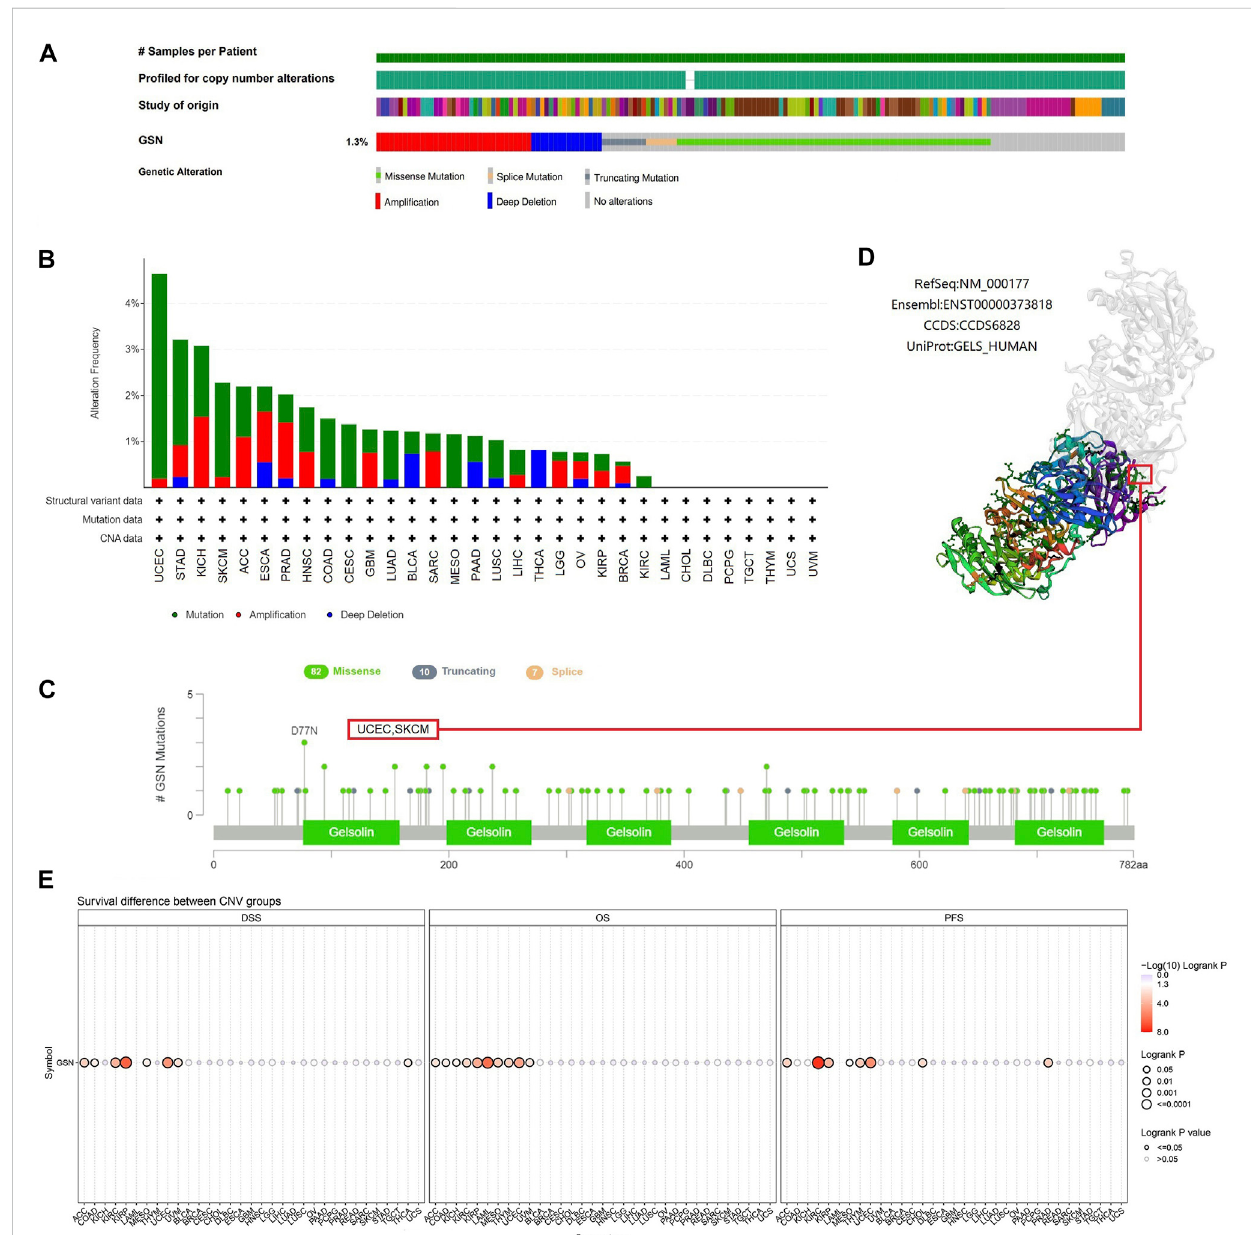
FIGURE 9 MutatedfeaturesofGSNindifferenttumors. (A) SummaryofchangesinGSNexpressionindifferenttumors. (B) BarplotofGSNalterationfrequency and types across different cancer types. (C) The landscape of GSN mutation with the location, types, and number and their relationship with protein domains. (D) Some GSN mutations are shown on the 3D structure of the protein. (E) Correlation between CNV in GSN and prognosis in cancer